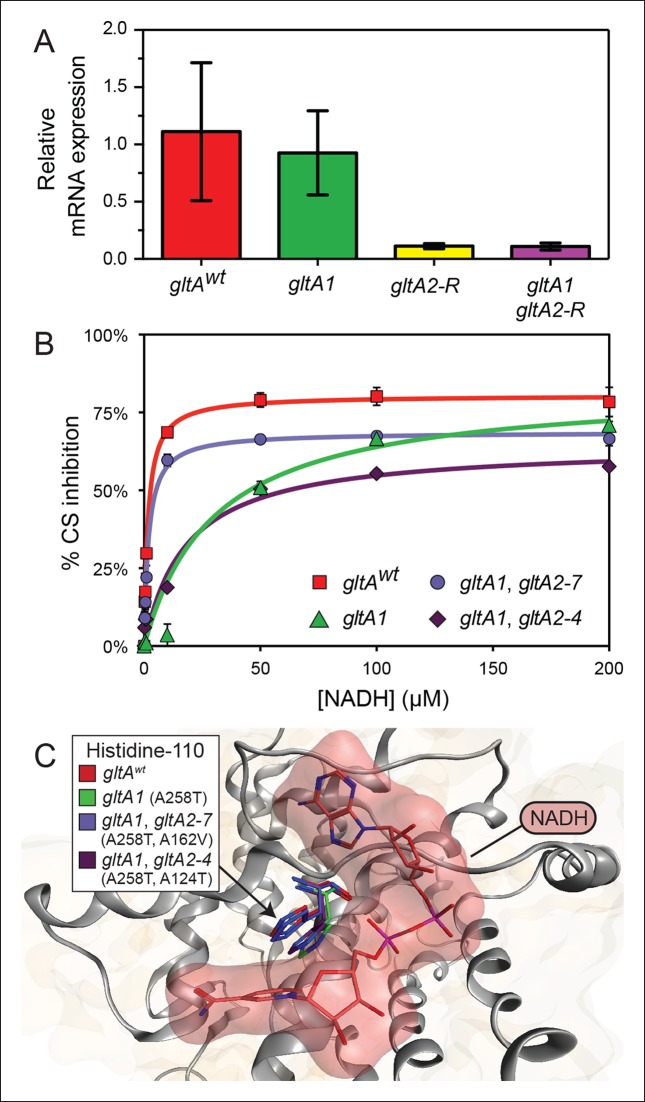
gltA mutations alter gene expression and allosteric regulation by NADH.(A) gltA mRNA expression levels as determined by qRT-PCR of EQ119-derived cells containing the specified ancestral or evolved alleles. Expression levels are shown relative to that of strain EQ119 which contains the gltAwt gene sequence. Error bars are 95% confidence intervals of biological triplicate samples. (B) NADH-mediated inhibition citrate synthase activity for the wild-type enzyme and evolved variants with combinations of gltA mutations. Fits to the hyperbolic model used to extract the binding and inhibition parameters in Table 1 are shown. Error bars are the S. E. M. of three replicates. (C) Molecular modeling predicts that the observed changes in allosteric regulation in evolved CS sequences are primarily caused by how mutations affect the orientation of histidine-110 in the NADH binding pocket. The gltA1 mutation is predicted to redirect this side chain into the binding pocket creating a steric clash with NADH (red surface). The two characterized variants of citrate synthase with an additional gltA2 mutation are predicted to reorient histidine-110 back toward the wild-type conformation. The degree of this predicted structural change correlates with the relative levels of NADH inhibition experimentally measured for these CS variants (Table 1).